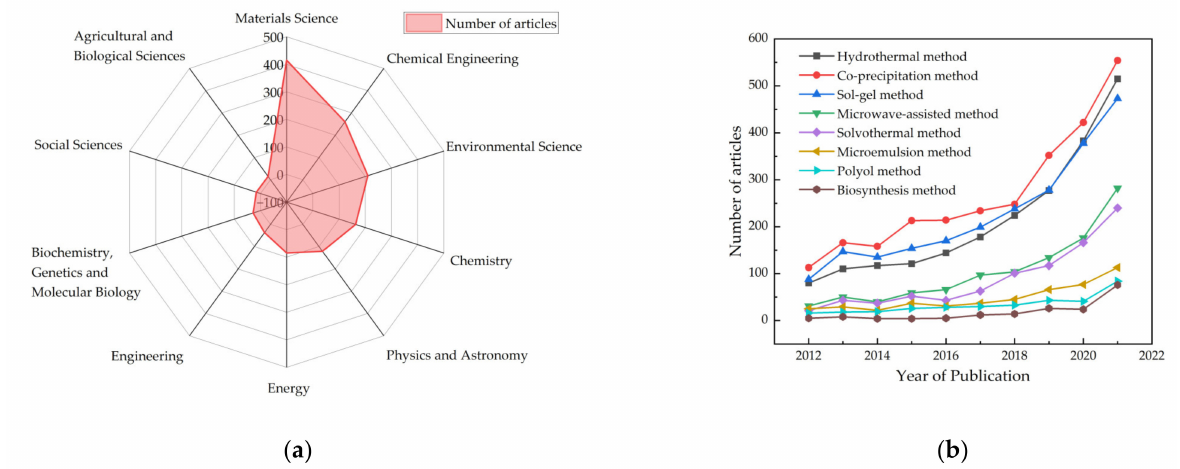
Figure 2. The literature survey on ZnFe 2 O 4 from 2012 to 2021: ( a ) fields of the relevant publications; ( b ) degree of attention to the different preparation methods